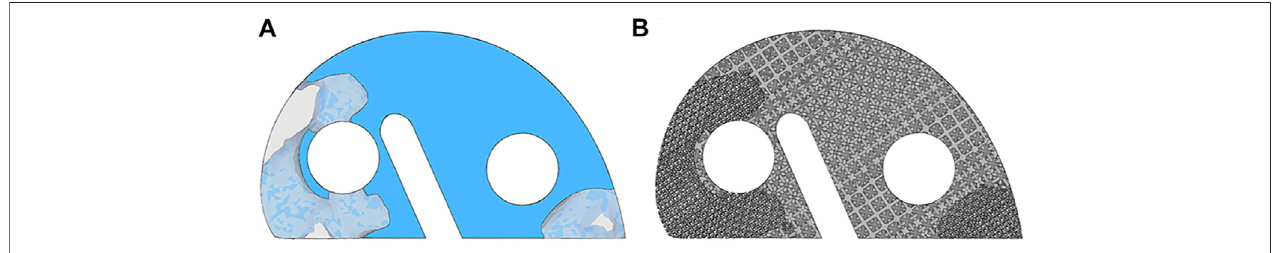
FIGURE 5 | Illustration of the topology optimization results and the newly designed porous metal block augmentation. (A) Topology optimization results. The component in the solid and the light shaded blue is the optimized part, and the remaining is the removed part. (B) Newly designed porous metal block augmentation.